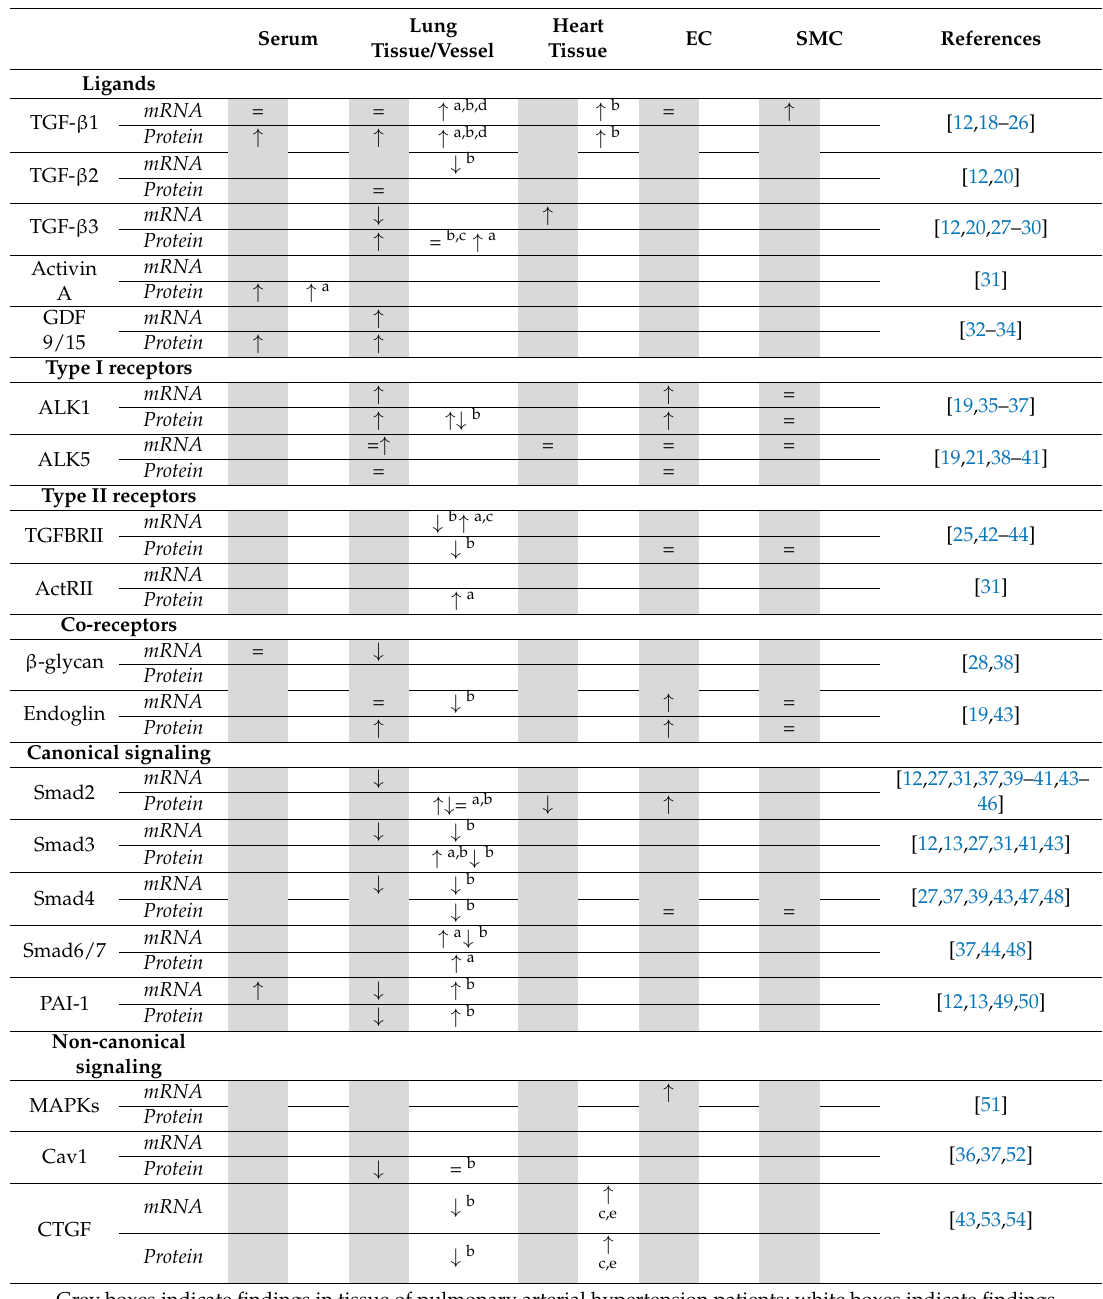
Table 1. TGF- β signaling in pulmonary arterial hypertension in human tissue and animal models.